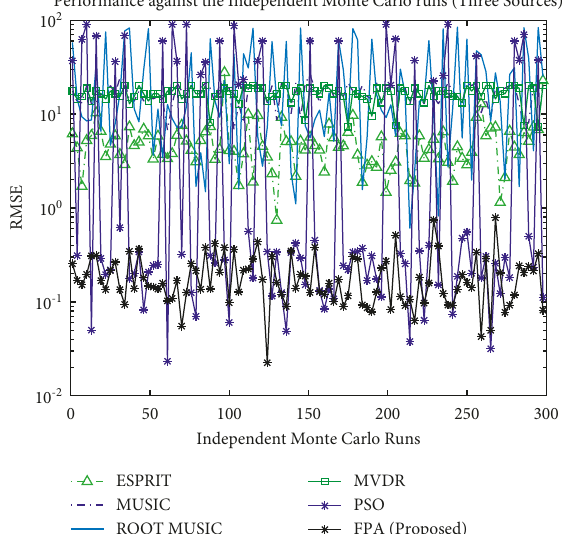
Figure 6: Performance against independent Monte Carlo runs for three sources with 5dB of SNR.